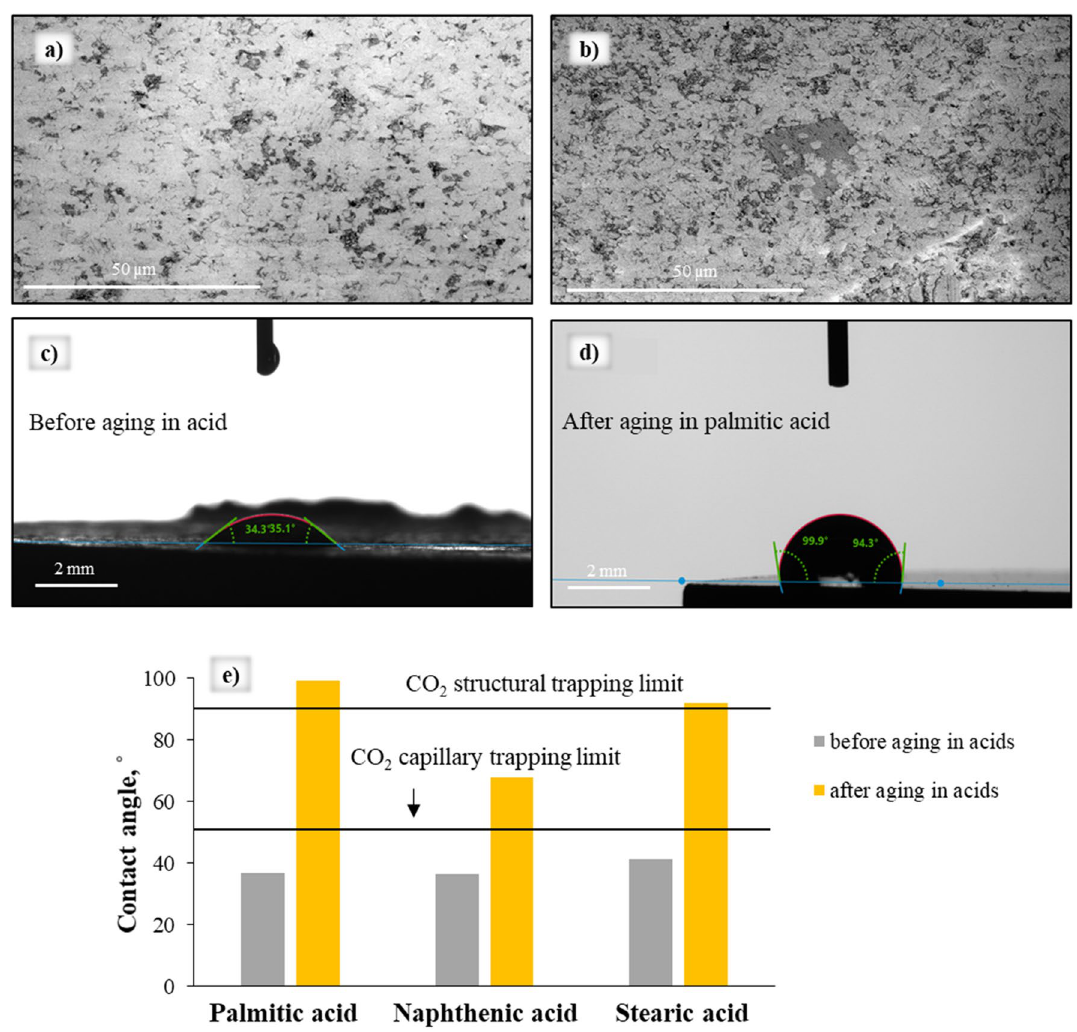
Figure 1. ( a , b ) SEM images of calcite surface before (left) and after (right) aging in palmitic acid; ( c , d ) examples of contact angle measurements on calcite surface before (left) and after aging (right) in palmitic acid; ( e ) Contact angle data for the samples before and after aging in different acids. Black lines indicate CO 2 capillary and trapping